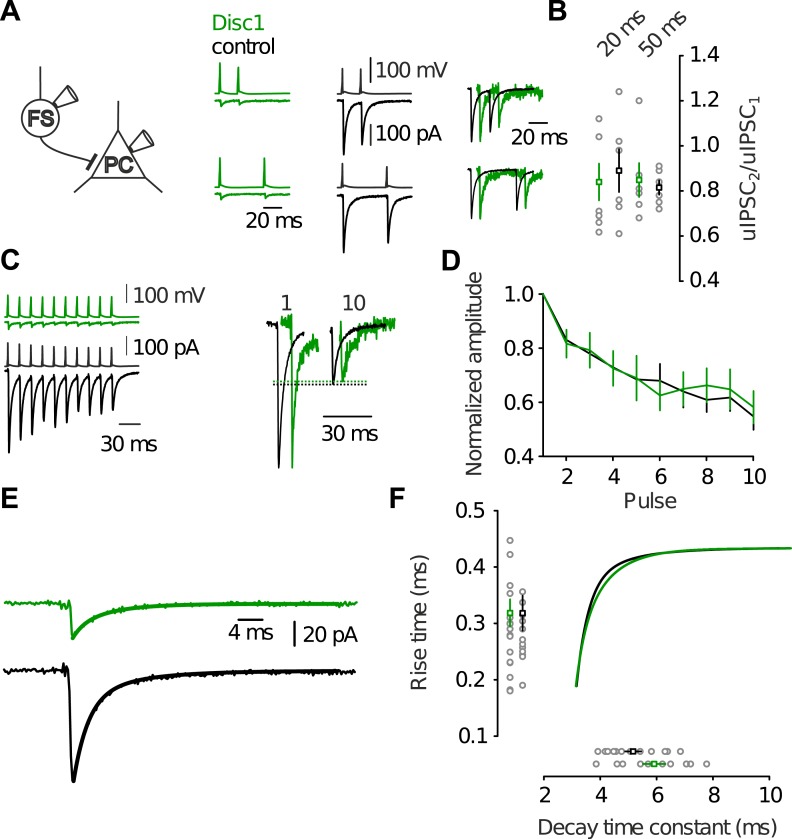
Identical dynamic and kinetic properties of uIPSCs at FS-IN output synapses.(A) Paired-pulse modulation in FS-IN-to-PC paired recordings was was determined from dual pulse stimulation (inter-pulse interval 20 or 50 ms) in paired recordings. Two presynaptic action potentials were evoked in the FS-IN at 20 ms and 50 ms inter-pulse interval. Amplitudes of uIPSCs were measured from the preceding baseline and the paired-pulse ratio (uIPSC2/uIPSC1) was quantified. (B) Summary of paired-pulse experiments show no significant difference in short-term dynamics of uIPSCs between both genotypes (20 ms, p = 0.836, n = 7 Disc1, 6 control pairs, 50 ms, p = 0.037, n = 6, 6). (C and D) Analysis of multiple-pulse modulation of uIPSCs elicited by trains of action potentials (10 pulses, 50 Hz) in paired recordings revealed identical modulation across genotypes (10th uIPSC/1st uIPSC, p = 0.671, n = 8, 7). (E) Determination of kinetic properties of uIPSCs. The solid lines represent biexponential fits to the decay phase of the average uIPSC. (F) Neither the 20–80% rise time (p = 0.985, n = 19, 13) nor the decay time constant (p = 0.193, n = 10, 11) differed between genotypes. Inner graphs shows the amplitude-scaled fits to the decay phase shown in E. Data are mean ± SEM.